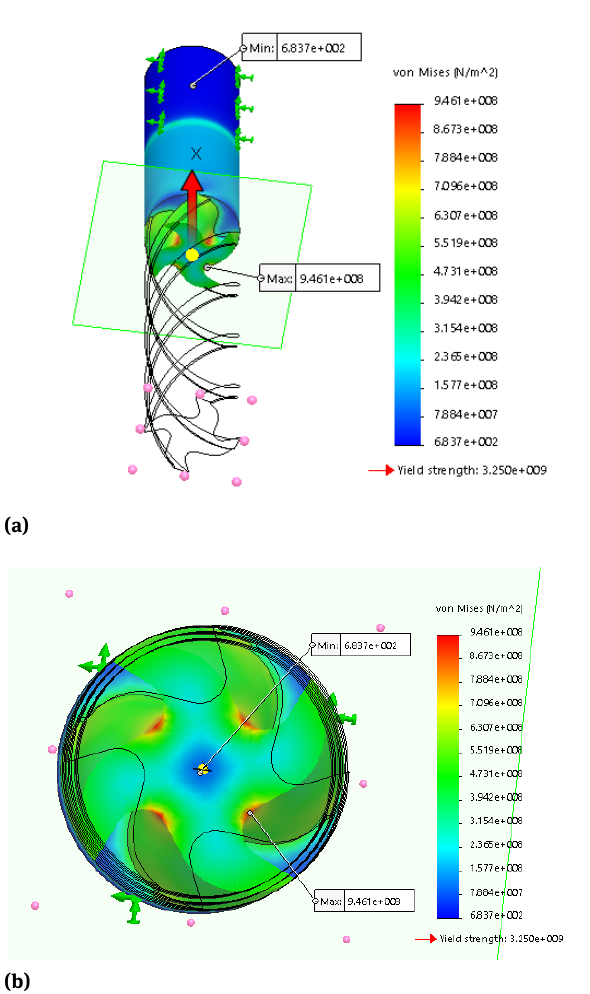
Figure 13: (a) Cross section location, (b) Cross section stress distri-